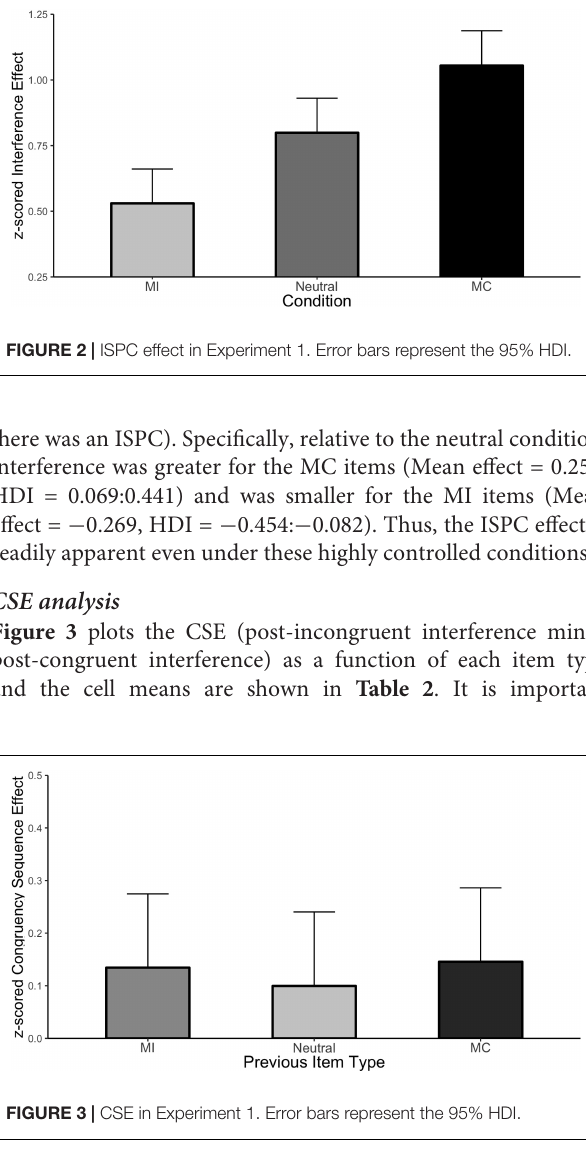
FIGURE 3 | CSE in Experiment 1. Error bars represent the 95% HDI.